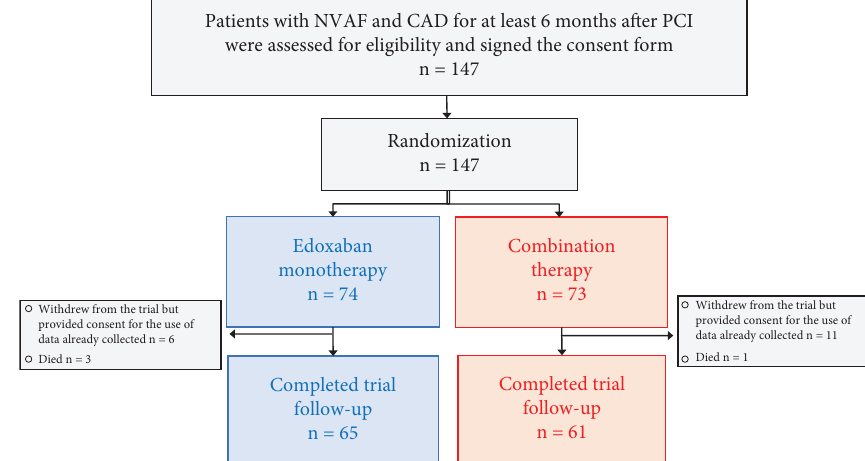
Figure 1: Flowchart showing the enrollment, randomization, and follow-up of the study patients. Te patients were randomly assigned at a 1:1 ratio to receive a monotherapy with edoxaban or a combination therapy with edoxaban and